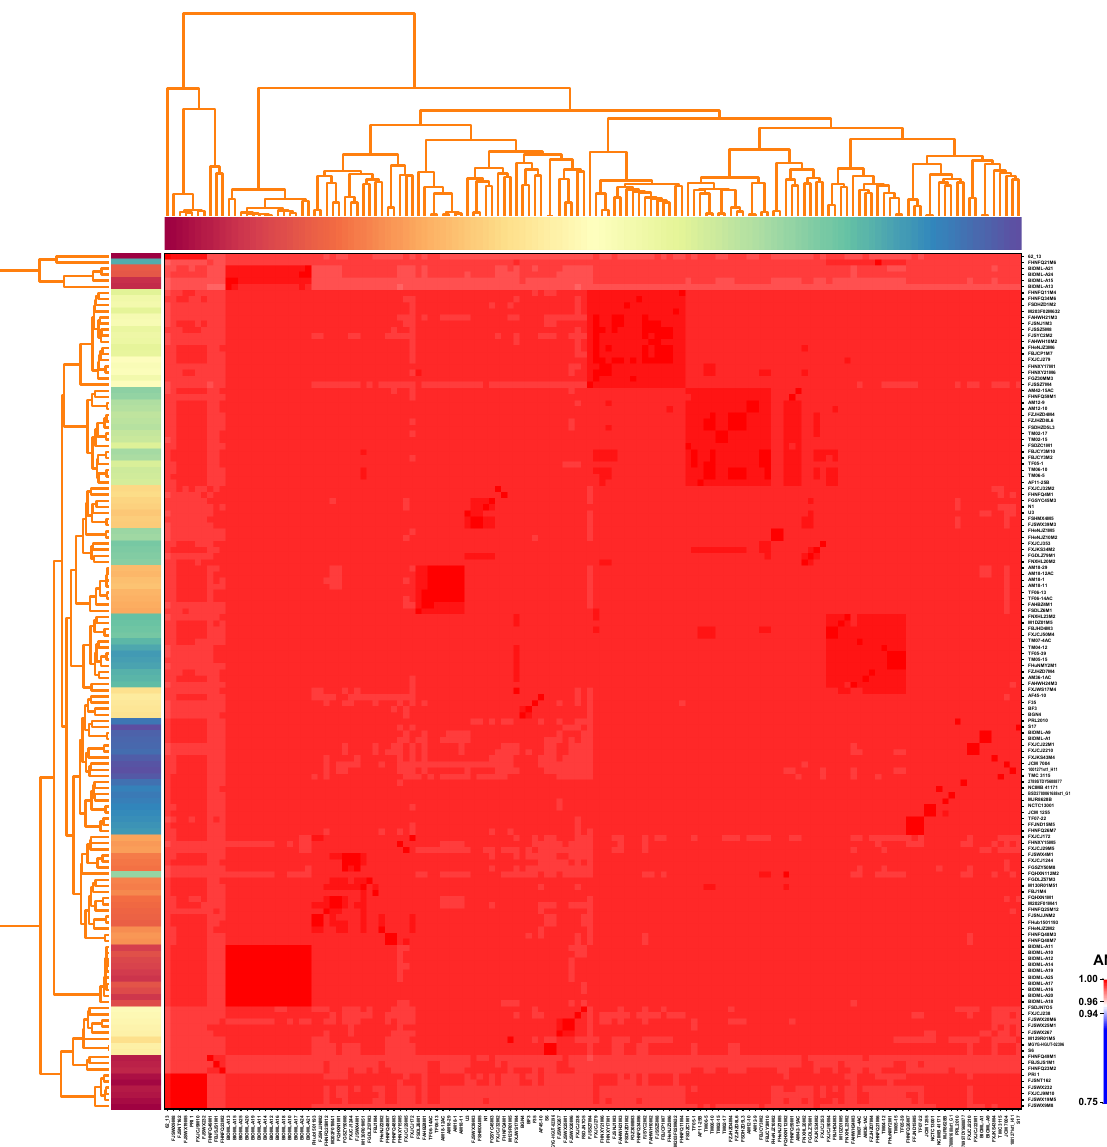
Figure 1. Pairwise average nucleotide identity values across 140 B. bifidum genomes. The color coding for the genomes on the x -axis and y -axis was used to differentiate the